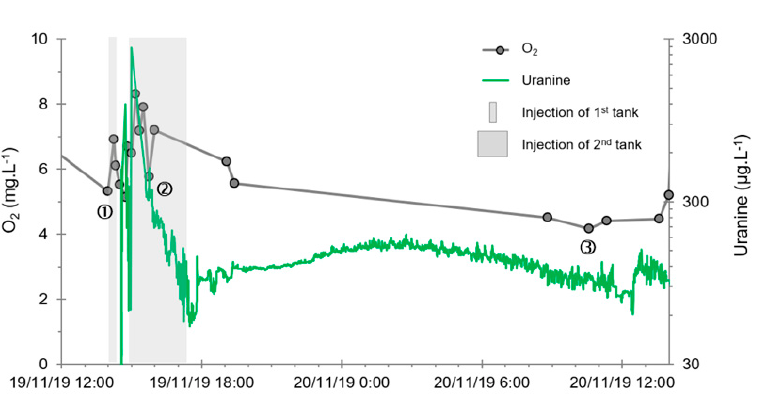
Figure 18. Detailed evolution of the dissolved oxygen and tracer concentrations at PZ2BIS (5 m down- stream) during the first day of dissolved hydrogen injection.